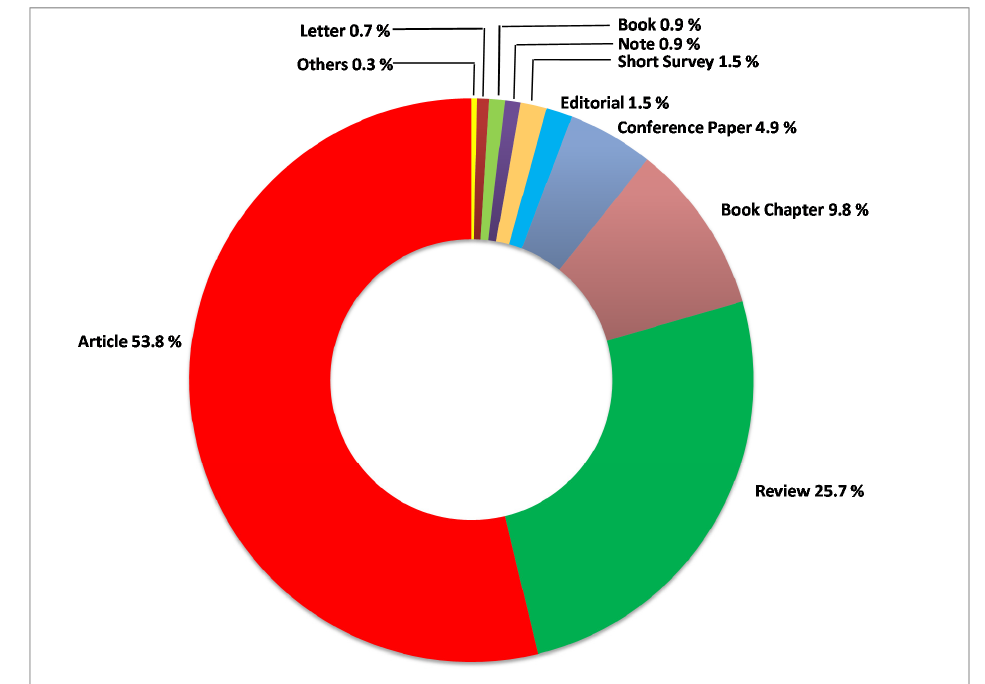
Figure 3. Distribution of documents by type. (Bibliometric data were extracted from the Scopus online database).